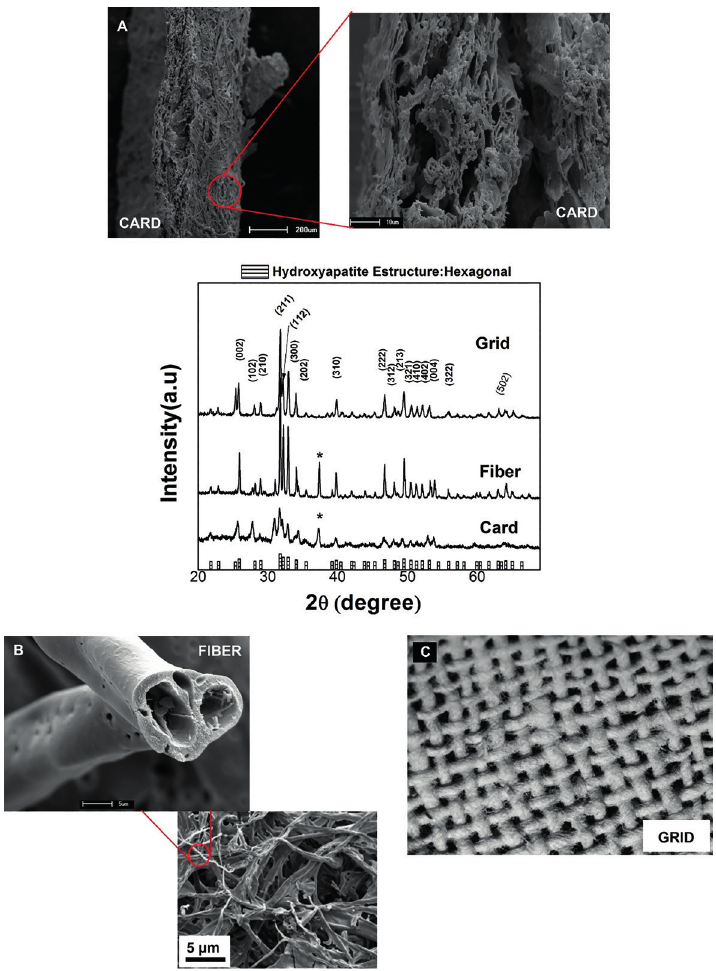
Figure 5. XRD and SEM images of (A) Card, (B) Fiber cotton, (C) Grid shape template of hydroxyapatite at 600 °C for 3 h.